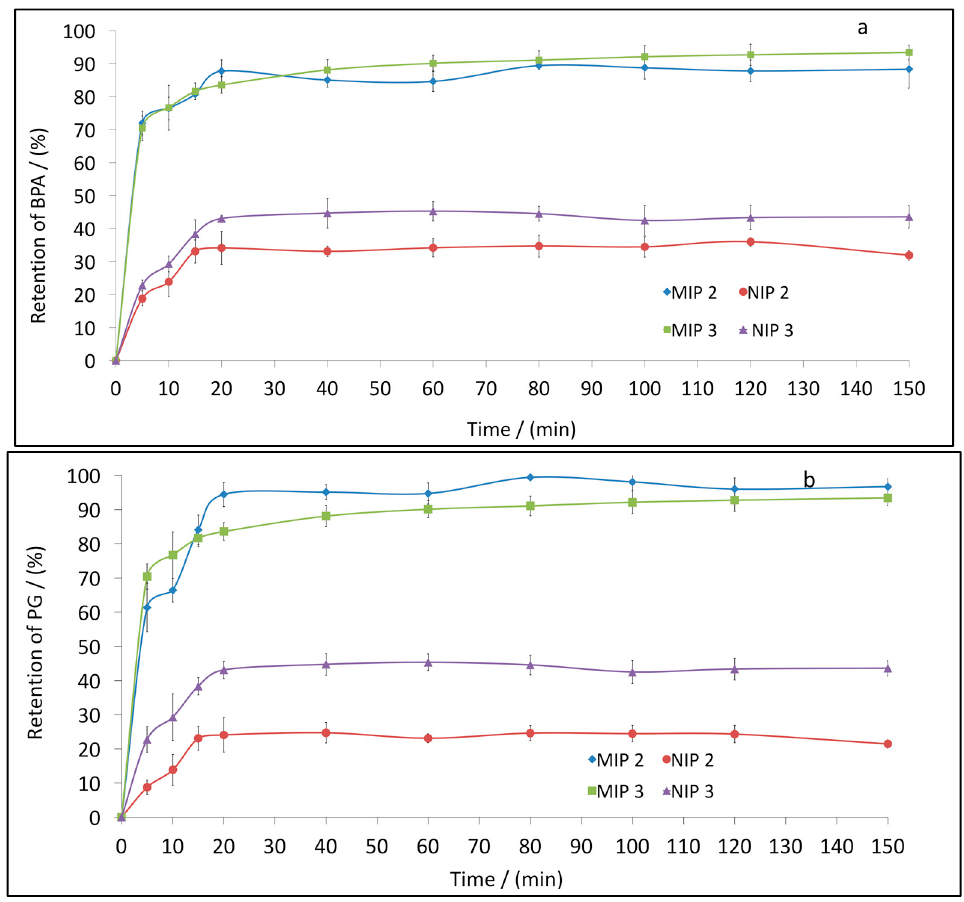
Figure 6. Kinetic study of the retention of BPA ( a ) and PG ( b ) with MIPs and NIPs. Error bars represent ±1 standard deviation. Experiments were performed in triplicate.